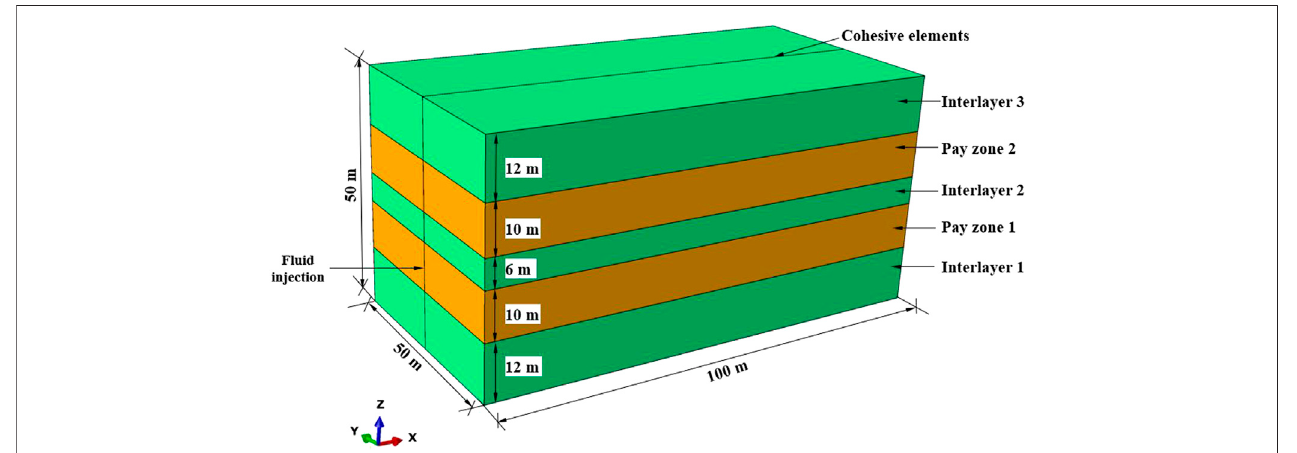
FIGURE 2 | Numerical model that consists of fi ve layers.